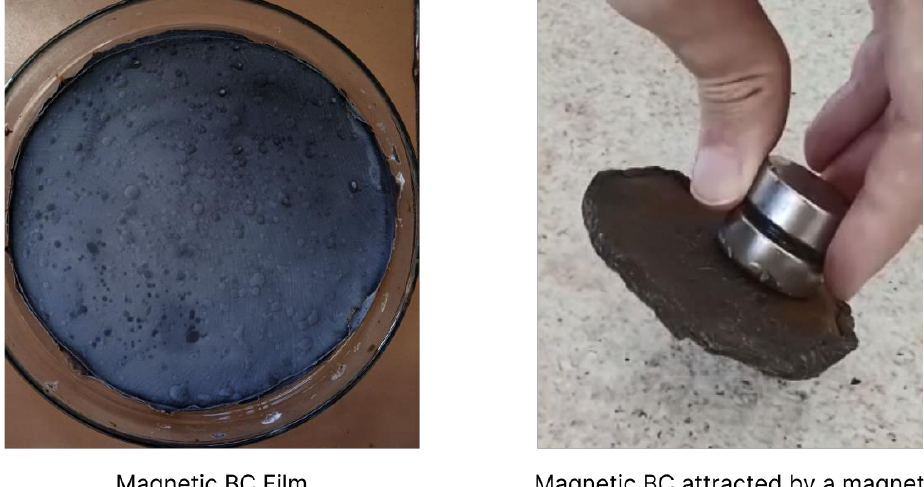
Figure 3. Magnetic BC: film produced through in situ co-precipitation of magnetite in BC fibres.